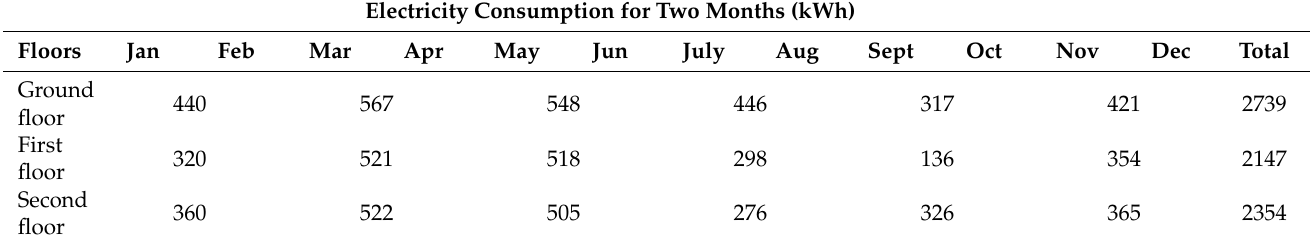
Table 5. Electricity consumption.